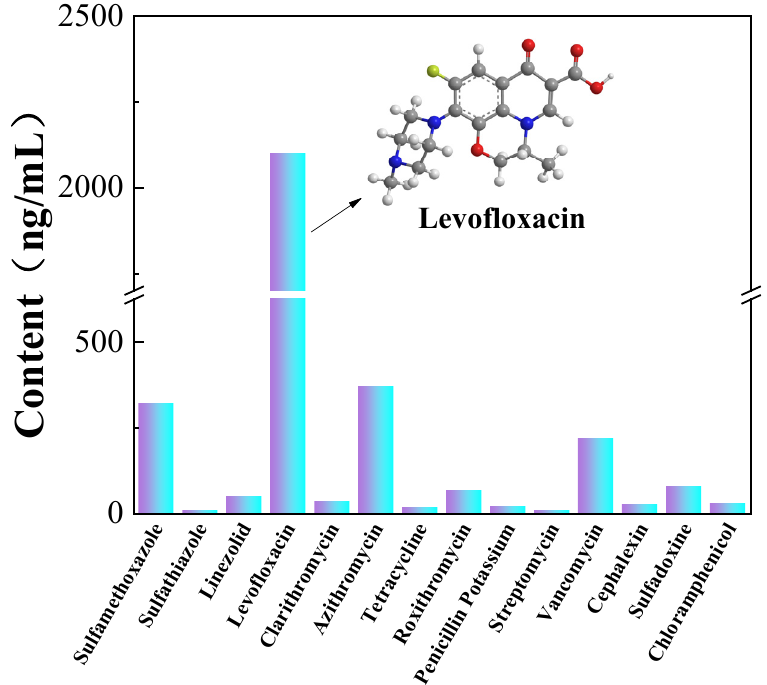
Figure 1. Antibiotic content in wastewater from novel coronavirus pneumonia epidemic.